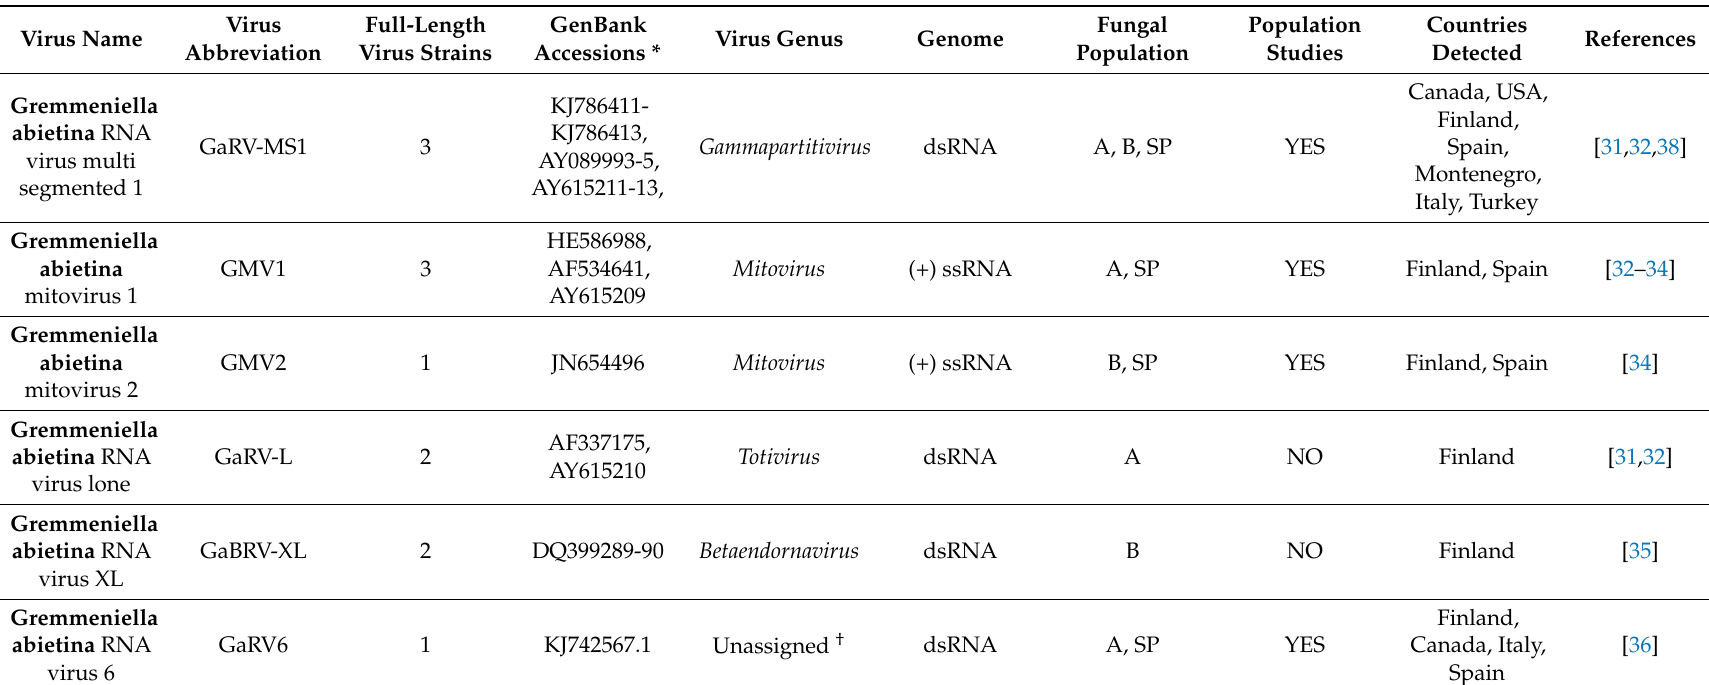
Table 1. Described viruses in G. abietina